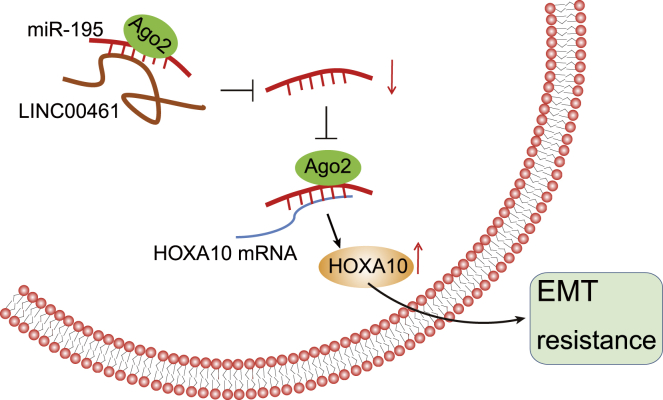
The graphical summary of the function and mechanism of LINC00461 in HNSCCLINC00461 competitively binds to miR-195 to upregulate HOXA10 expression, thereby inducing EMT and enhancing chemoresistance of HNSCC cells.